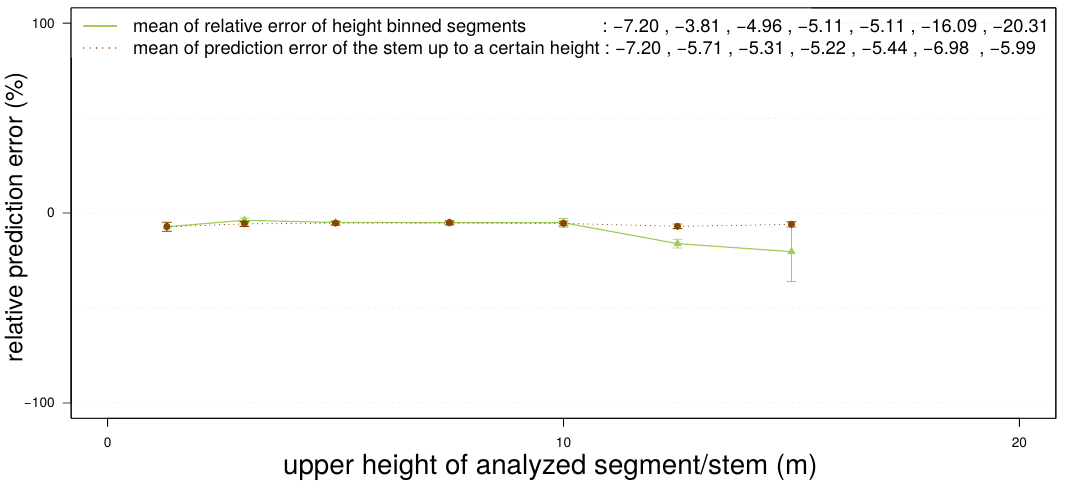
Figure 10. Prediction quality analysis of the stem of 12 E. fordii . The green graph describes the averaged prediction error for all segments taken from the same height. The brown graph represents the prediction error of the cumulative volume of all stem segments up to a certain height. Both graphs include the standard error in form of error bars.